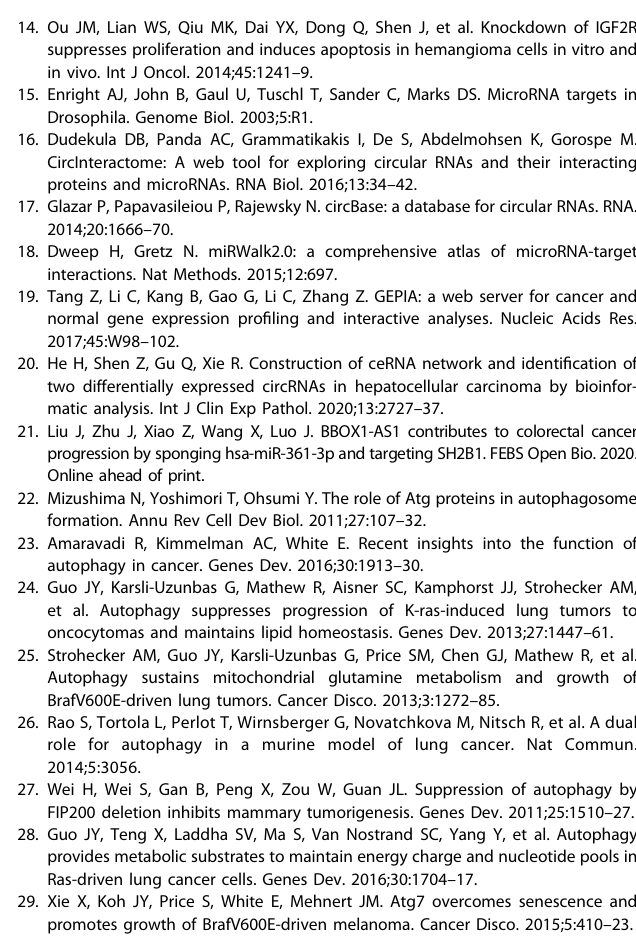
Fig. 6 CircRNA hsa_circ_0007813 regulated autophagy through hsa-miR-361-3p/IGF2R. The siRNA-transfected cells (siCirc) were further transfected with hsa-miR-361-3p miRNA inhibitor (InhiMIR). These cells were subjected to A qRT-PCR (N = 3, Kruskal – Wallis test) and D western blot analysis assays. The siRNA-transfected cells (siCirc) were further transfected with IGF2R overexpression vectors (VectOE). These cells were subjected to B qRT-PCR ( N = 3, Kruskal – Wallis test) and E western blot analysis assays. After hsa-miR-361-3p miRNA mimic (MimicMIR) transfection, cells were further transfected with IGF2R overexpression vectors (VectOE). These cells were subjected to C qRT-PCR ( N = 3, Kruskal – Wallis test) and F western blot analysis assays. GAPDH was used as a loading control. All error bars in the fi gures indicated the standard deviation of three independent experiments. * P < 0.05, ** P < 0.01, *** P <